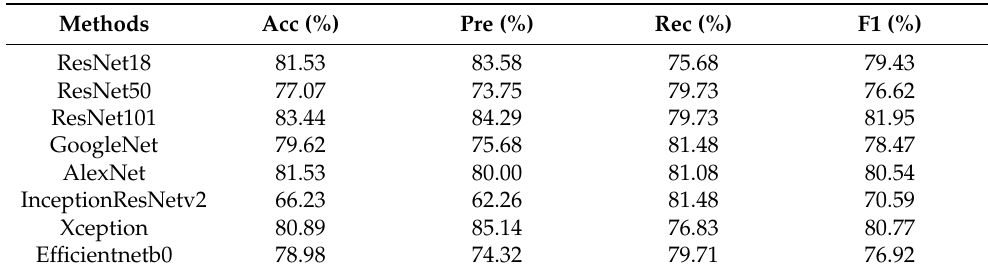
Table 2. Classification results based on different